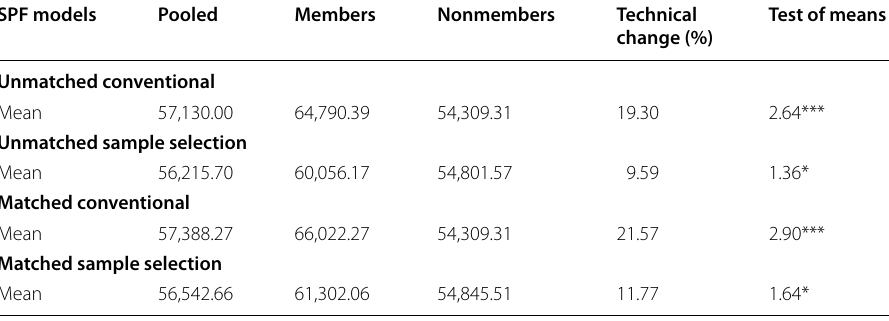
Table 7 Predicted frontier output for unmatched and matched